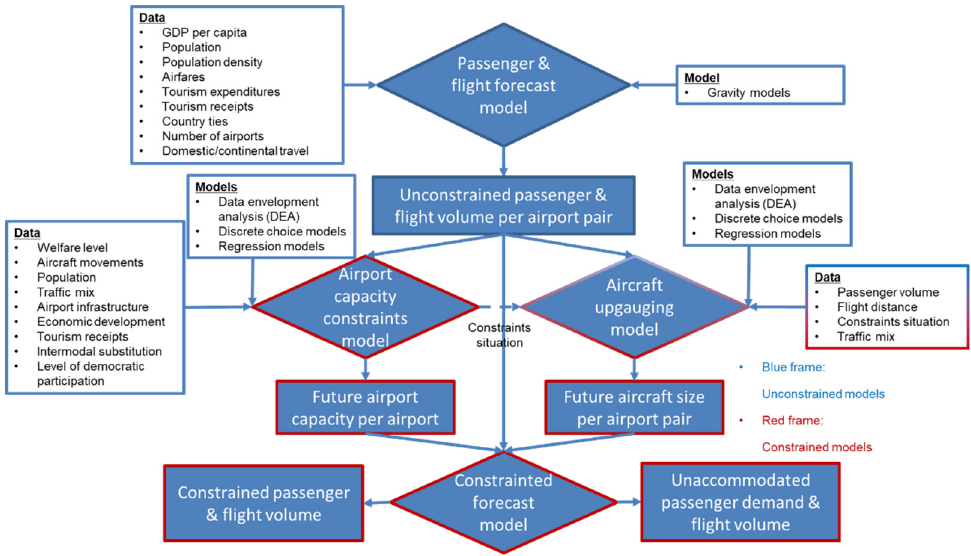
Figure 1. Overview of the forecast model (own illustration).